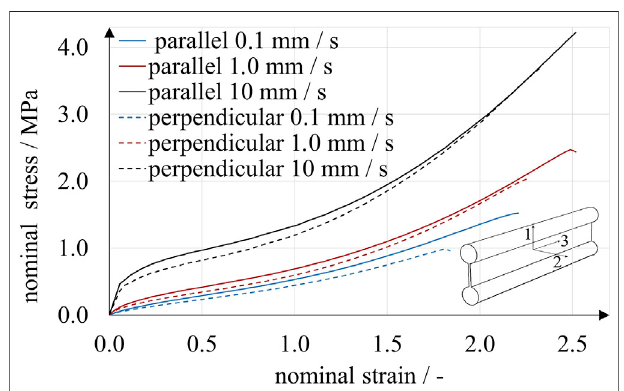
FIGURE 5 | Planar tensile experiments with A30 specimens. Two print directions and three loading rates were compared. While the effect of loading rate on stress was considerable, print direction had a distinct but smaller